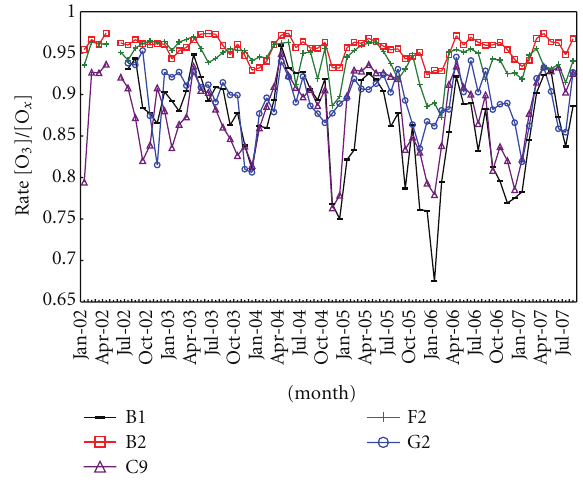
Figure 4: Monthly rate [O 3 ]/[O x ], with O x = O 3 + NO 2 , at five monitoring stations (B1-A Magdalena, B2-Louseiras, C9- Mourence, F2-Fraga Redond, and G2-Vilanova) during the period from January 2002 to August